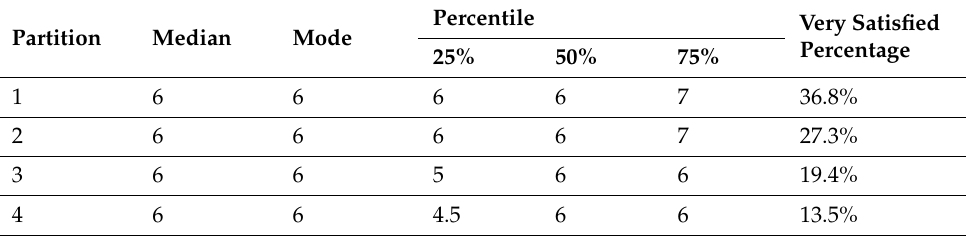
Table 5. Artificial landscape data statistics.